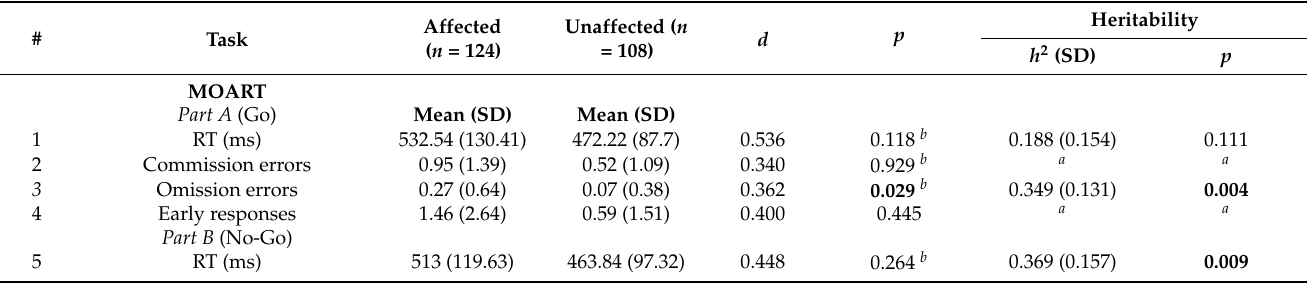
Table 2. Performance of 232 individuals from the Colombian Caribbean on TP and RT-based neurological and neuropsychological